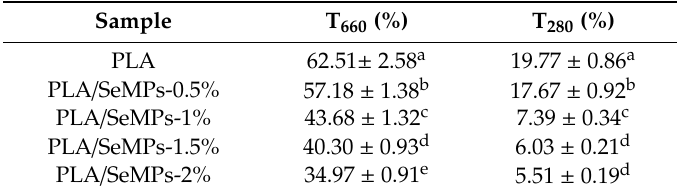
Table 4. Transmittance of di ff erent volume ratio of PLA and PLA / SeMPs